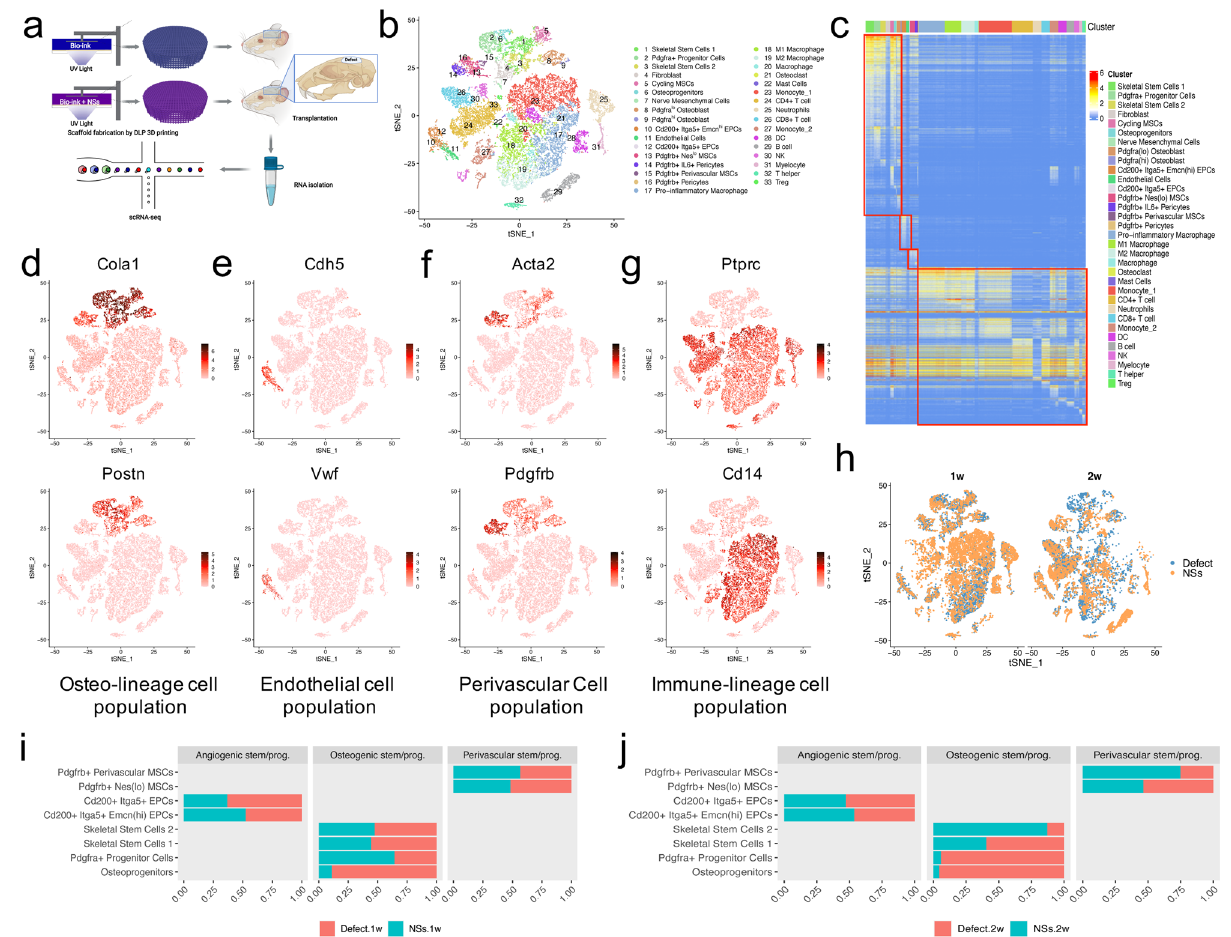
Fig. 3|Fourcellclustersweredifferentiallyregulatedbyinsituculturesystem with NSs during bone regeneration. a Work fl ow of sample isolation, mRNA libraries preparation, and single-cell RNA sequencing of regenerated tissue from critical-sized calvarial defects with or without the implantation of in situ culture system of NSs-loaded 3D printed hydrogel scaffold, at both 1 week and 2 weeks after defect surgery. n =6 rats per group and per time point (Created with BioRender.com). b tSNE plot shows the distribution of 26016 cells that divided into 33 sub-clusters. c Heatmap shows expression of marker genes of the 33 sub-clusters. Marker genes were selected according to p value (Wilcoxon